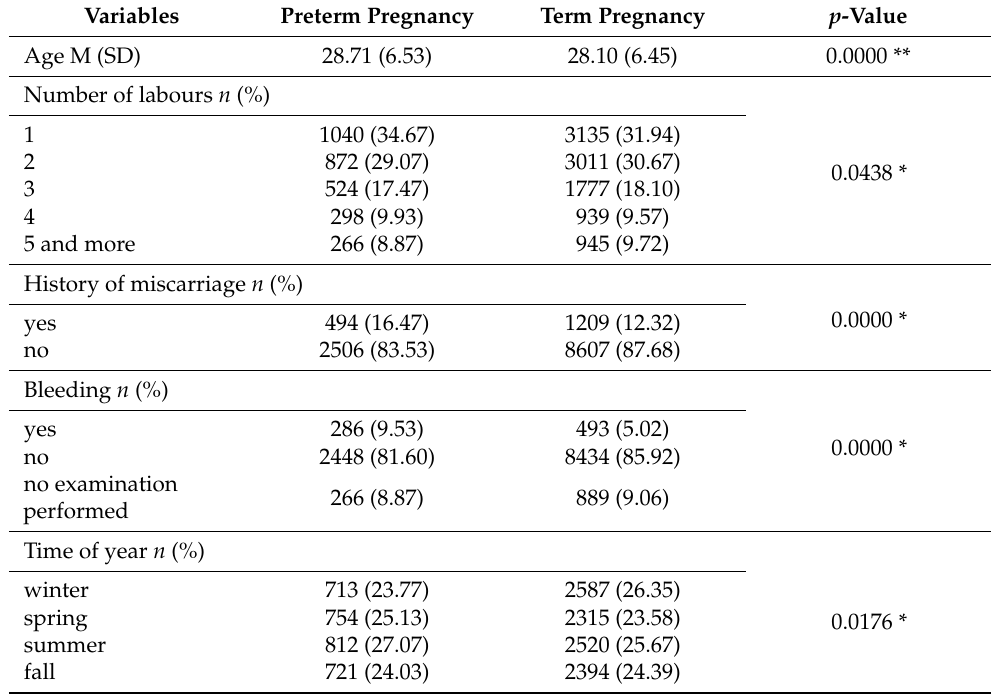
Table 4. Analysis of associations between duration of pregnancy and selected